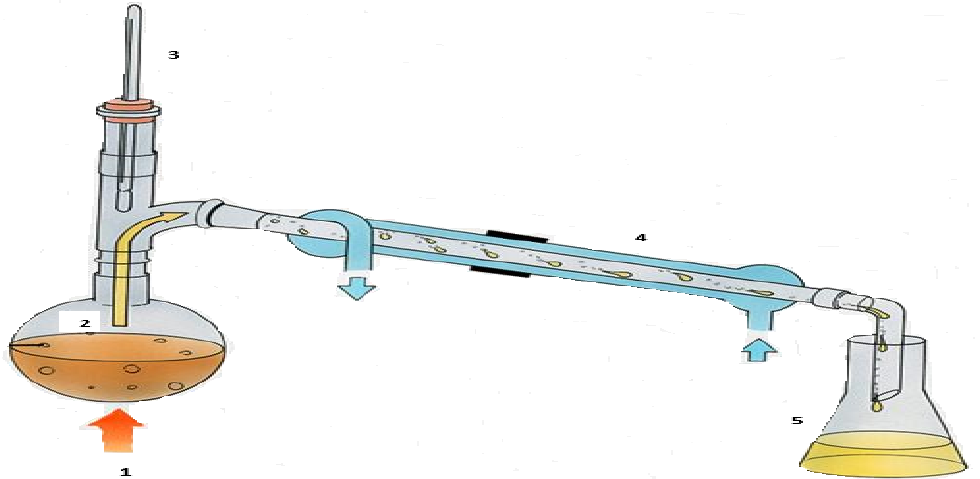
Figure 4. Waste tire pyrolysis distillation schematic: 1—Heat source; 2—Waste tire pyrolytic oil; 3—Thermometer; 4—Water condenser; 5—Distilled pyrolytic oil.